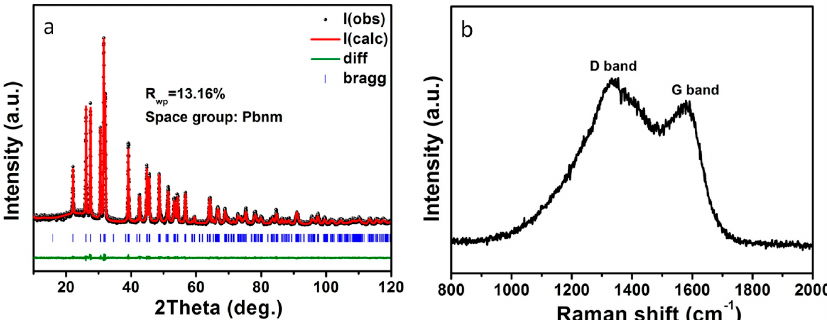
Figure 2. ( a ) X-ray diffraction patterns and Rietveld refinement results; and ( b ) Raman spectrum